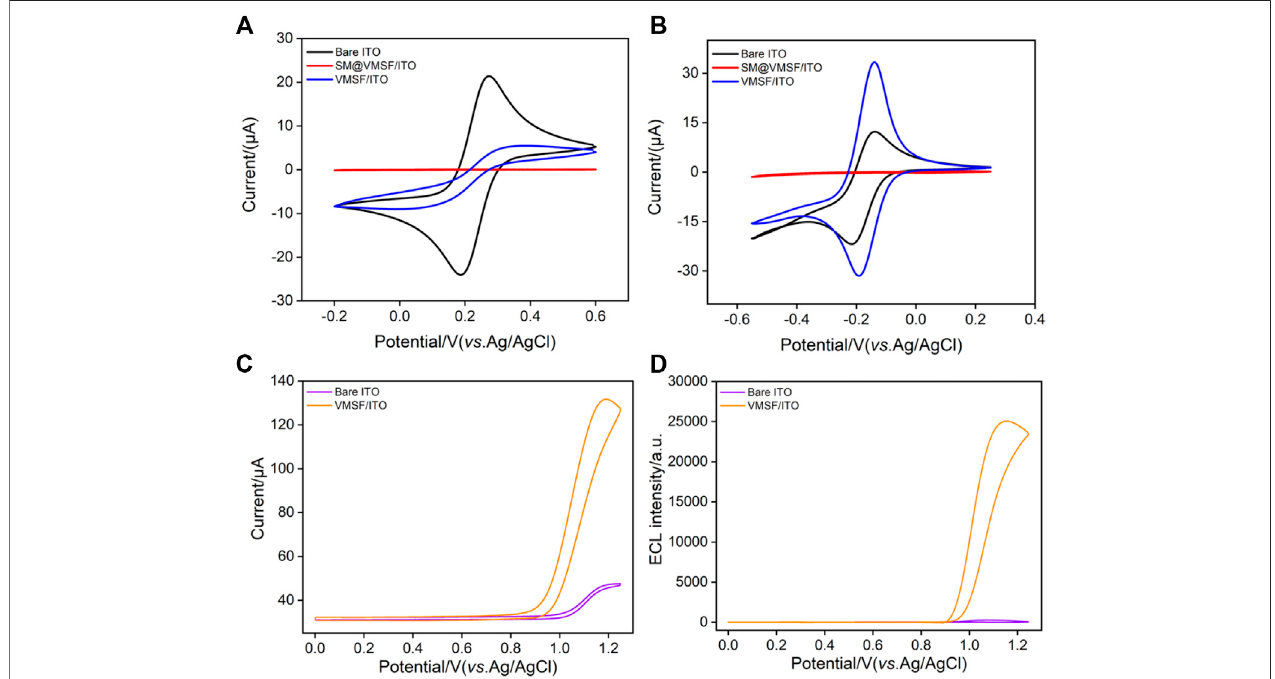
FIGURE 3 | Cyclic voltammetric curves of (A) K 3 [Fe(CN) 6 ] (0.5 mM) or (B) Ru(NH 3 ) 6 Cl 3 (0.5 mM) on the bare ITO, SM@VMSF/ITO, and VMSF/ITO electrodes in KHPsolution(0.05 M,pH=7.4).Thescanrateis50 mV s − 1 .Cyclicvoltammetriccurves (C) andECLintensity-potentialcurves (D)